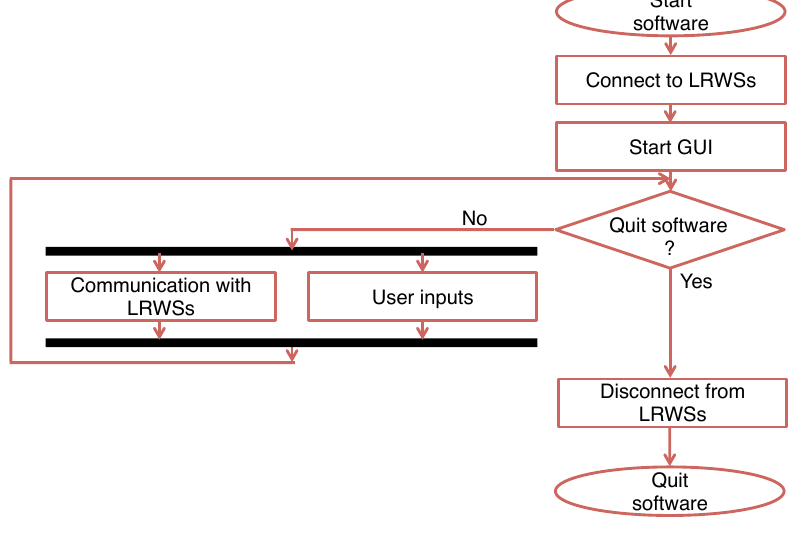
Figure 6. MCS flow